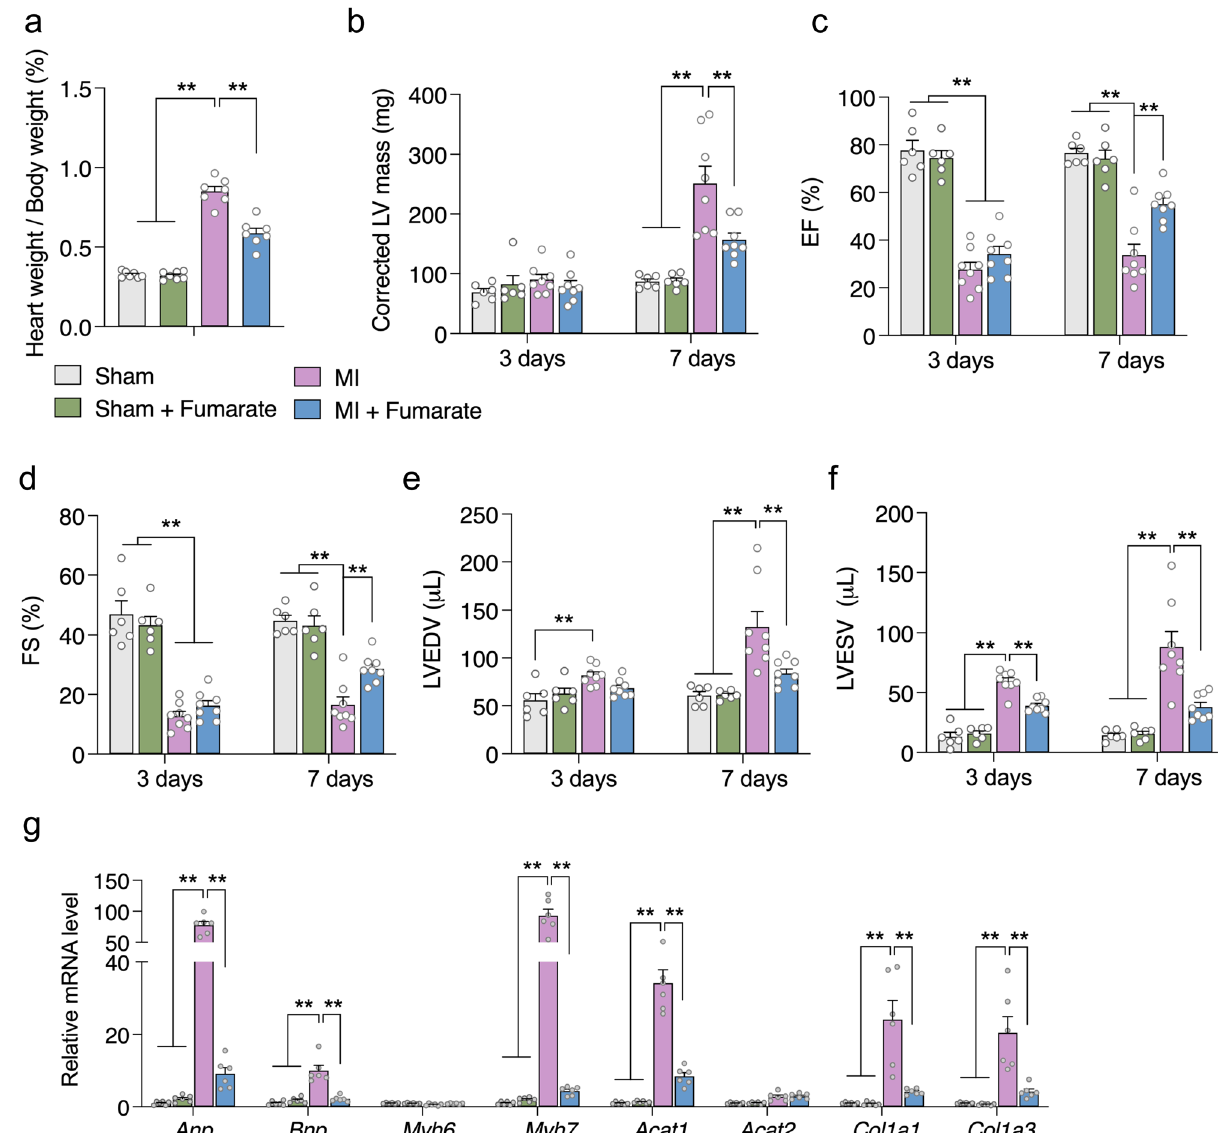
Fig. 8 Fumarate supplement improves cardiac function in MI mice. a Heart weight / bodyweight ratio of control and MI mice with or without fumarate supplement for 7 days, n = 7, P < 0.0001. b – f Heart function measurements of control and MI mice with or without fumarate supplement for 3 and 7 days ( n = 6 for Sham and Sham + Fumarate groups, n = 8 for MI and MI + Fumarate groups): corrected LV mess ( b , P < 0.0001), EF ( c , P < 0.0001),